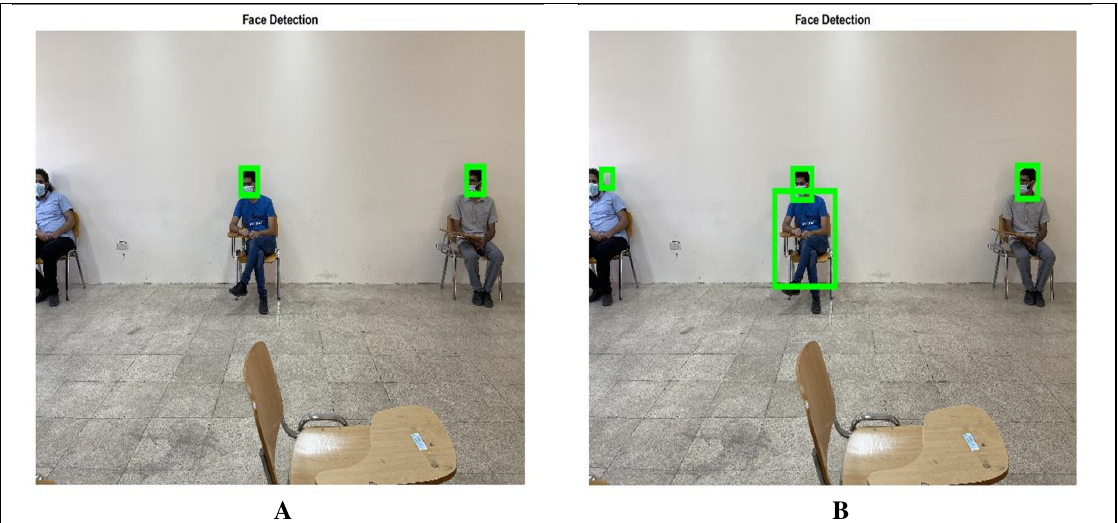
Fig. 6. Face detection A. Using HOG features. B. Using LBP features.